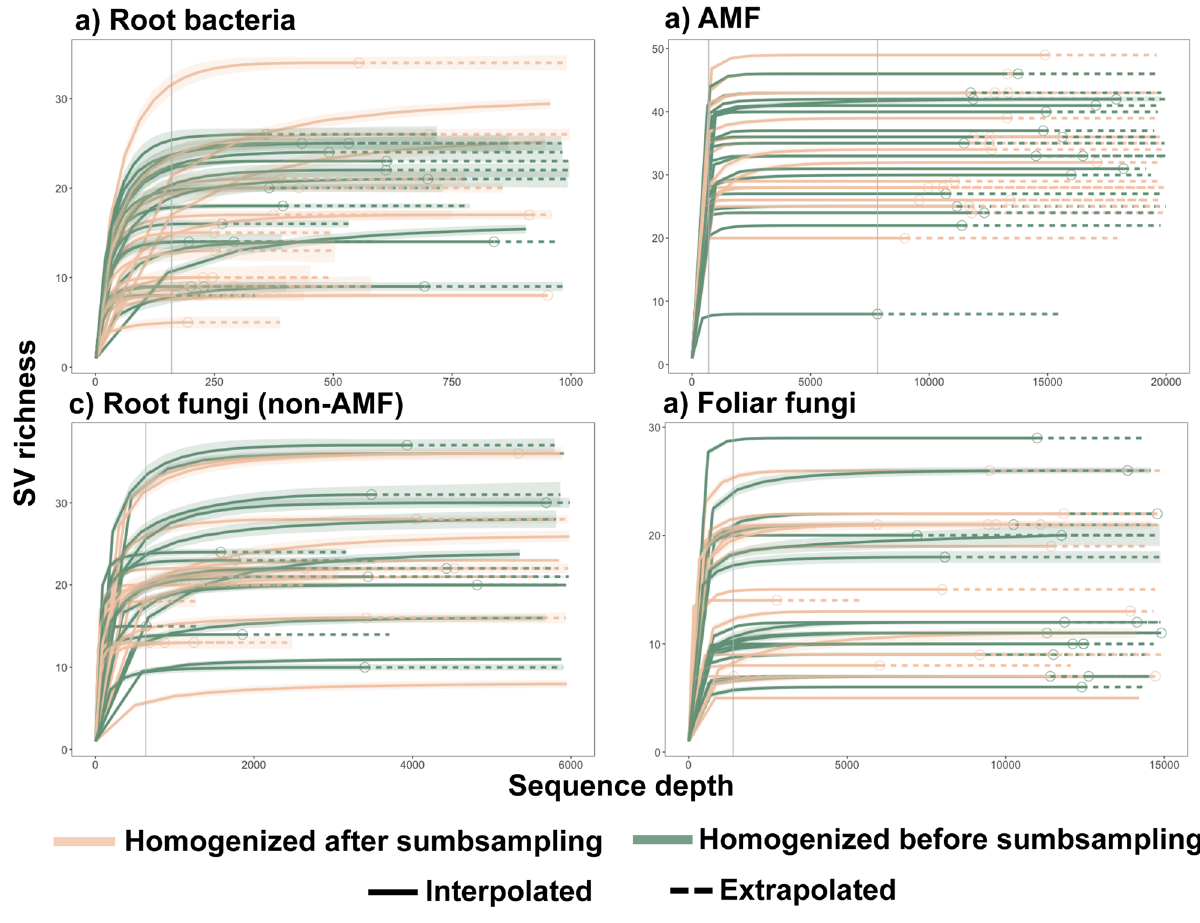
Figure 2. Sequence rarefaction curves for each sampling strategy (homogenizing after subsampling and homogenizing before subsampling) for ( a ) bacteria in roots, ( b ) Arbuscular mycorrhizal (AM) fungi in roots, ( c ) all non-AM fungi in roots and ( d ) foliar fungal endophytes, in Asclepias speciosa plants. Vertical lines represent the sequencing depth(s) at which each group was